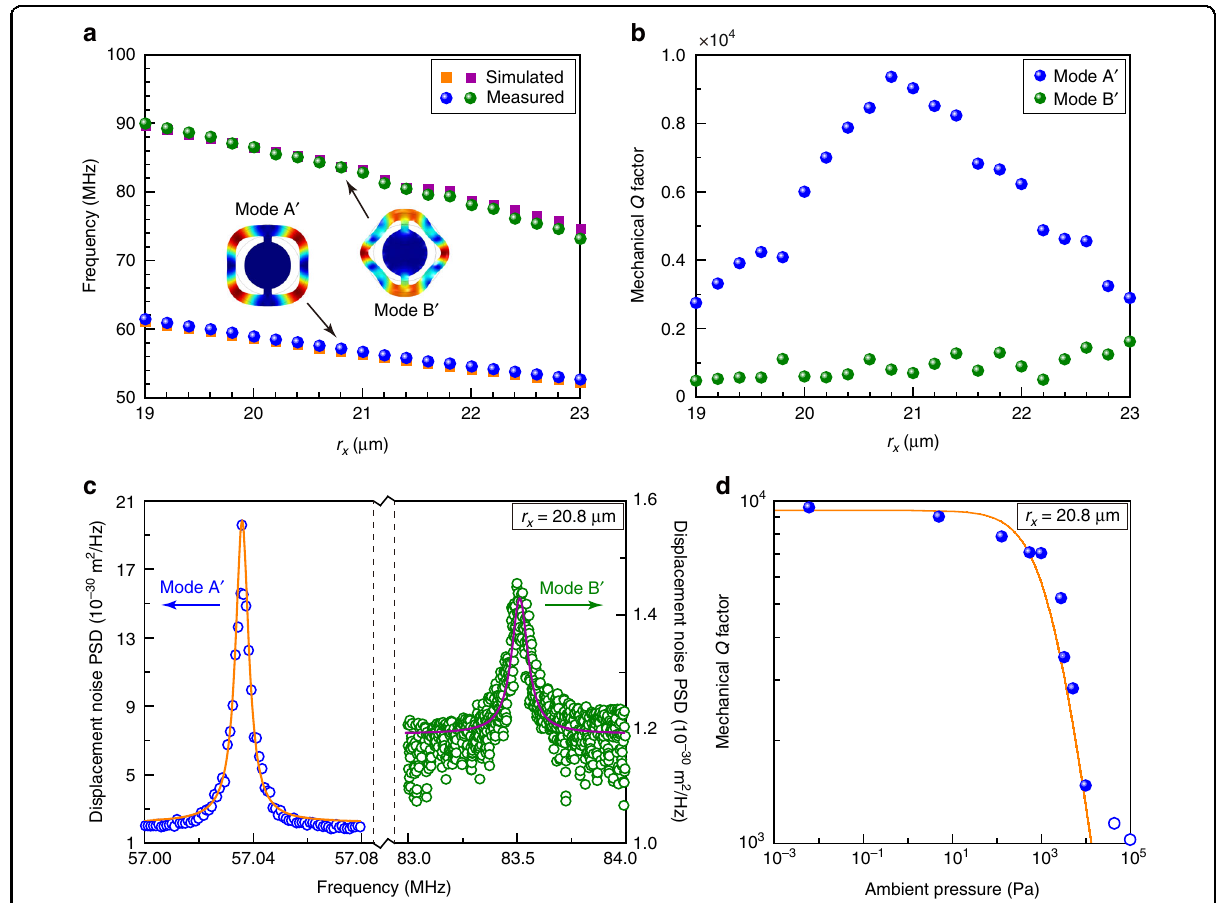
Fig. 4 Experimental demonstration of mechanical BIC in an optomechanical microresonator. a Simulated and measured frequencies of modes A' and B' as a function of r x . b Measured mechanical Q factors of modes A' and B' as a function of r x under the ambient pressure of 6.0 × 10 − 3 Pa. c Measured displacement noise power spectral density (PSD) of modes A' and B' from the device with r x = 20.8 μ m under the ambient pressure of 6.0 × 10 − 3 Pa. The blue (green) open circles represent the measured data points for mode A' (B'), and the orange (purple) line is the corresponding Lorentzian fi t. d Measured mechanical Q factor of mode A' from the device with r x = 20.8 μ m as a function of the ambient pressure. The data collected below (above) 10 4 Pa are marked in blue dots (open circles). The orange curve plots a theoretical fi t for the blue data points (below 10 4 Pa) based on Eq.